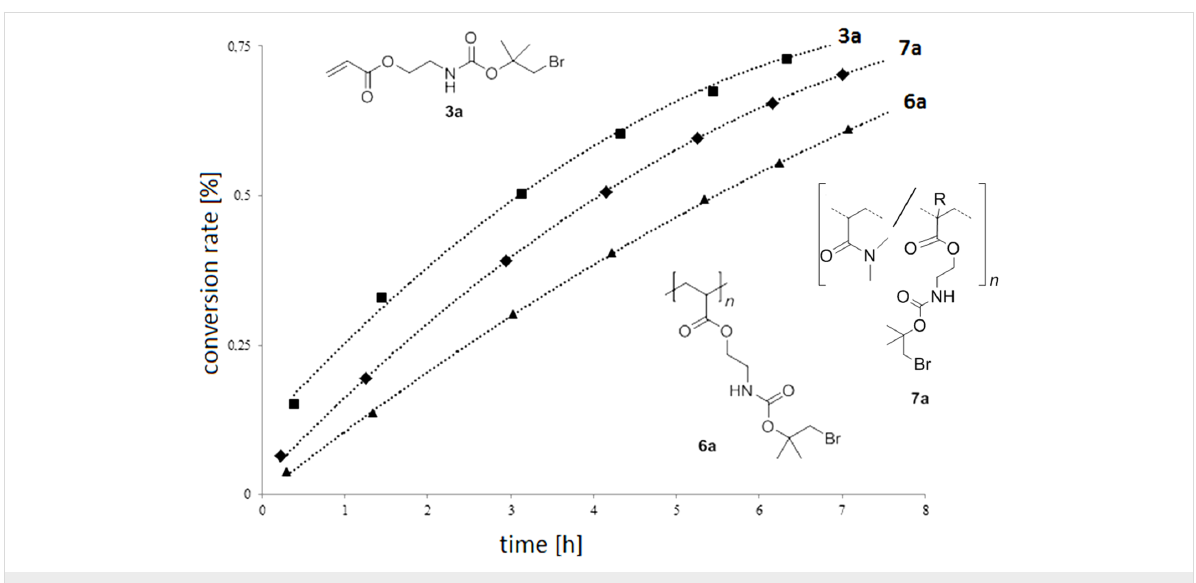
Figure 4: Kinetic studies of the deprotection of 3a , 6a and 7a .